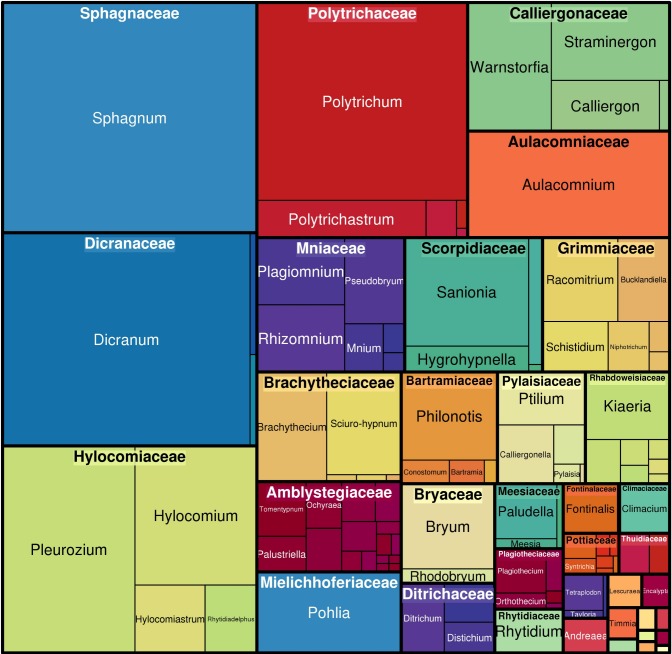
Taxonomic distribution of occurrences amongst moss families in the dataset. The figure was prepared with the “treemap” package in R (Tennekes 2017).